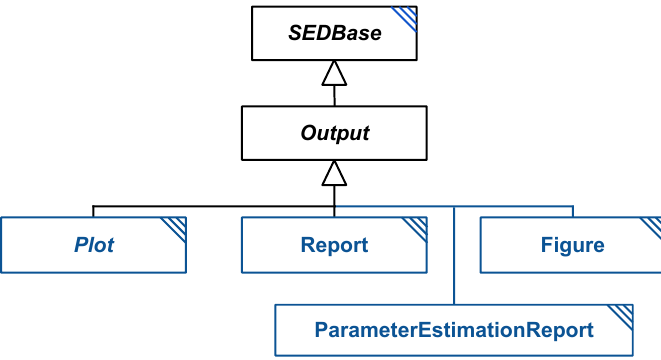
Figure 2.20: The definition of the SED-ML Output class. The subclasses are defined